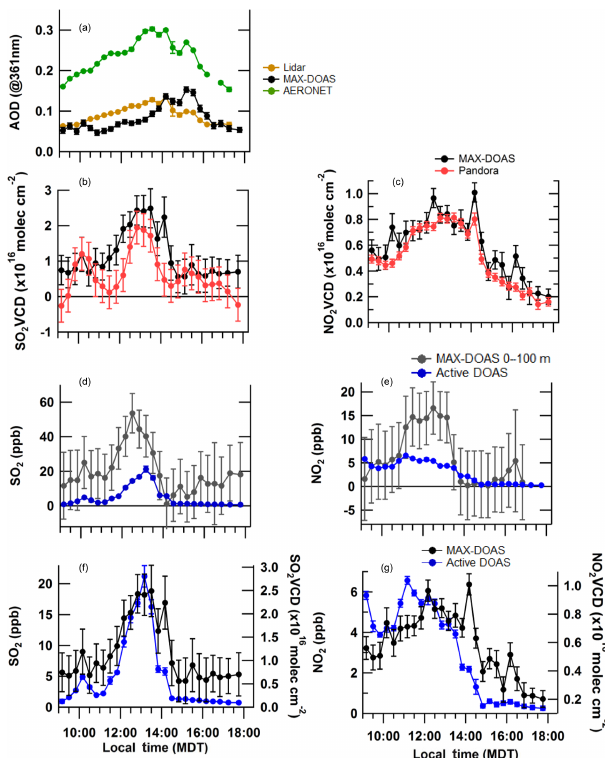
Figure 7. The 5 September AODs from MAX-DOAS, lidar, and AERONET (a) ; MAX-DOAS SO 2 VCDs (b) ; MAX-DOAS NO 2 VCDs (c) ; MAX-DOAS 0–100m and active DOAS SO 2 mixing ratios (d) ; MAX-DOAS 0–100m and active DOAS NO 2 mixing ratios (e) ; MAX-DOAS VCDs and active DOAS mixing ratios of SO 2 (f) ; and MAX-DOAS VCDs and active DOAS mixing ratios of NO 2 (g) . MAX-DOAS error bars were obtained from the optimal estimation retrieval. Error bars on the lidar and AERONET AODs are the standard error of the temporally averaged values. Error bars on the active DOAS mixing ratios are root-sum-square errors of the standard error from averaging and the DOASIS retrieval error. See Sect. 2.3.3 for